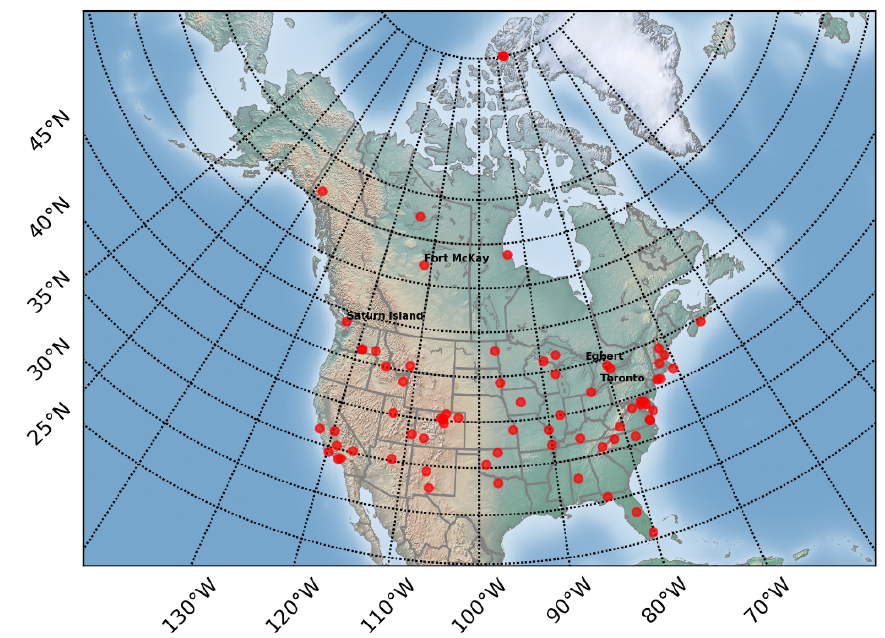
Figure 4. North American AERONET sites. AOD data from these stations are used in this